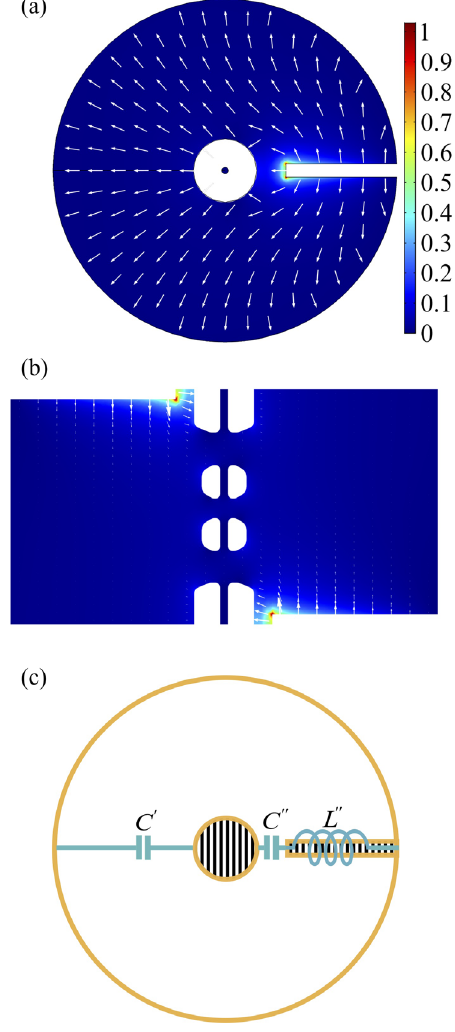
FIG. 16. (a) The electromagnetic field distribution in the cell boundary plane cutting through a post coupler. The intensity of the electric field is shown by colors normalized to one. Arrows show the direction of the electric field. (b) Corresponding horizontal cross-section with the same scaling. (c) The equivalent circuit of the PC 0 mode of the post